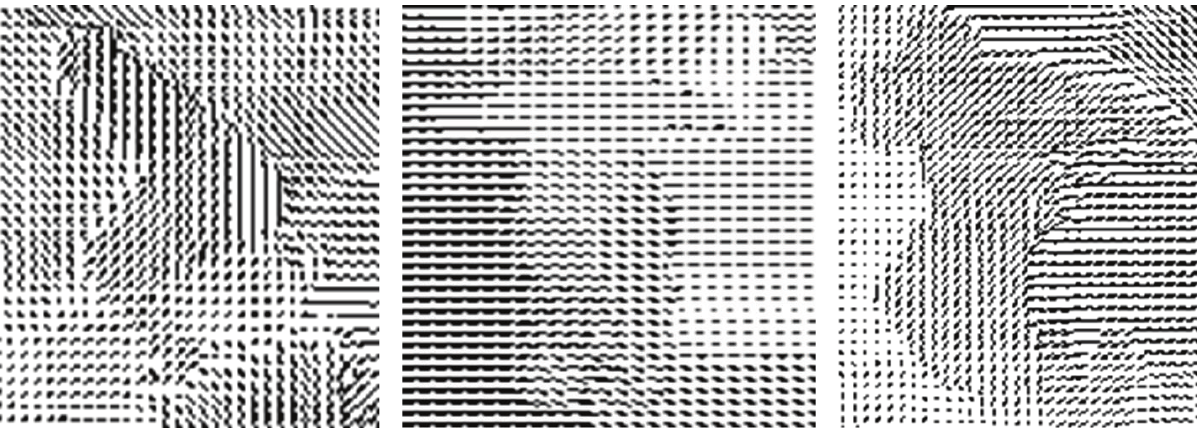
Figure 7: Examples of depth silhouettes images using motion-based optical